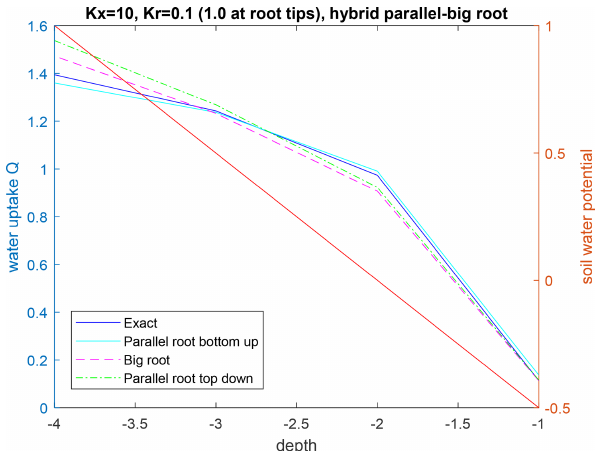
Figure 5. Upscaled water uptake profiles (left axis) and soil water potential distribution (right axis; red line) for the hybrid parallel– big root system with radial conductances along the primary root branches that vary along the branches (radial conductance is 1 at root tips and 0.1 at other nodes), with the parallel root model with bottom-up parameterization ( SUF and K rs derived from exact model), the big root model, and the parallel root model with top- down